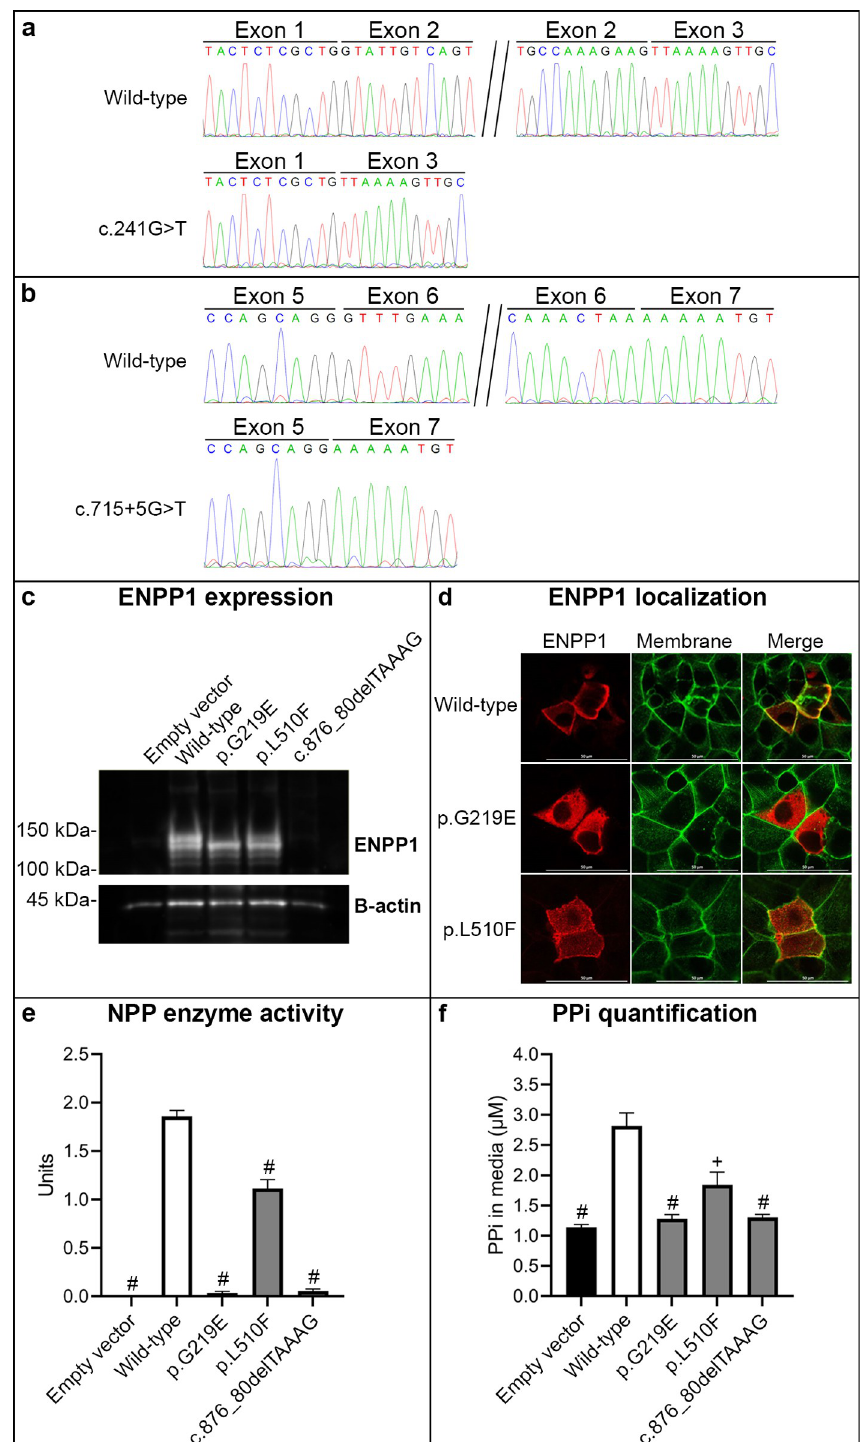
Fig 3. Functional characterization of five previously unreported ENPP1 variants, c.241G > T (p.V81L), c.715 +5G > T, c.656G > A (p.G219E), c.1530G > C (p.L510F) and c.876_880delTAAAG. ( a ) Sanger sequencing of RT-PCR products from leukocytes in patient #7 carrying the c.241G > T variant showed skipping of exon 2. ( b ) The splicing of ENPP1 mini-gene pre-mRNA from transfected HEK293 cells was assessed by RT-PCR using a forward primer specific to the mini-gene and a reverse primer targeting the vector’s Flag-tag sequence, which allows splicing of the mini-gene-